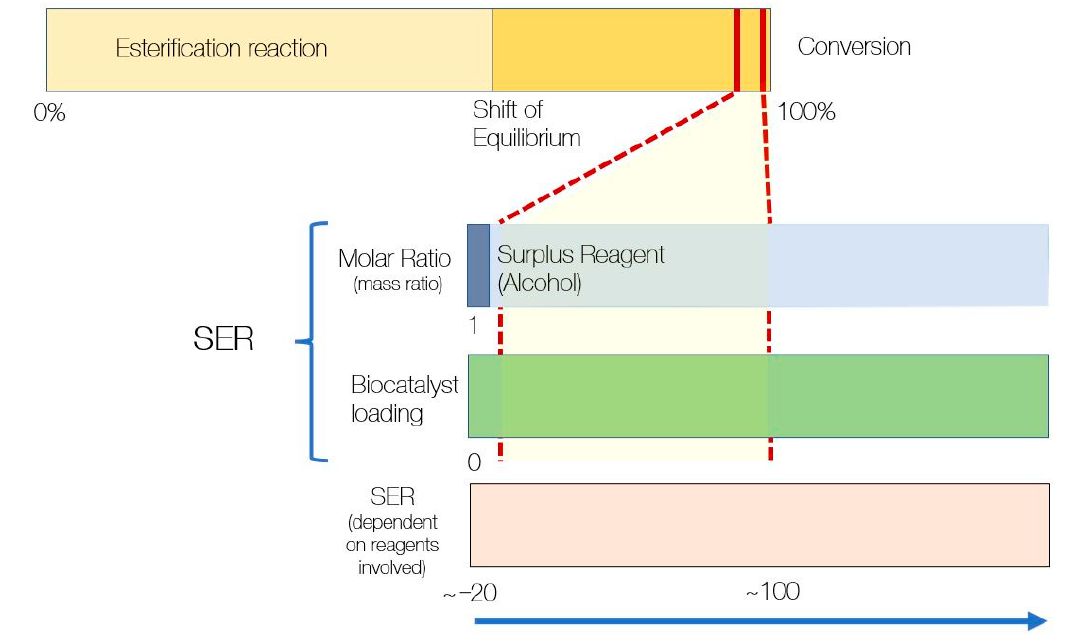
Figure 1. Graphical representation of the optimal reaction condition (molar ratio and biocatalyst loading) range for optimizing enzymatic esterification and its mathematical expression using SER.